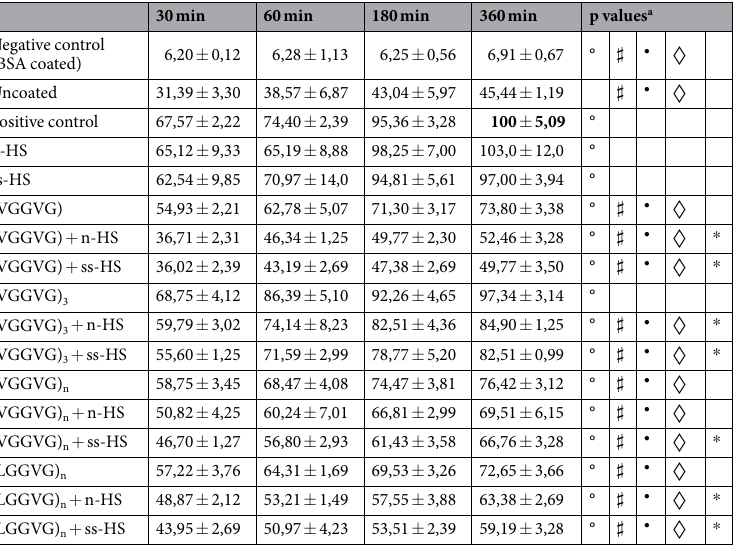
Table 2. Adhesion assay on bacteriology Petri dishes uncoated or coated. The percentage of adherent cells after 30, 60, 180 and 360 minutes compared to positive control (tissue culture plates) at 360 min set at 100. Data are expressed as mean ± SD of three experiments performed at least in triplicate. Differences were considered significant for p < 0.05. a) °All conditions vs uncoated; # All conditions vs positive control; • All conditions vs n-HS alone; ◊ All conditions vs ss-HS alone. * ELP + n-HS/ss-HS vs the same ELP alone. a p values reflect time dependent variations of cellular adhesion analysed by hyperbolic curve. Best fit values, standard errors and degrees of freedom obtained from each condition were compared using one way analysis of variance (ANOVA) followed by post hoc Tukey